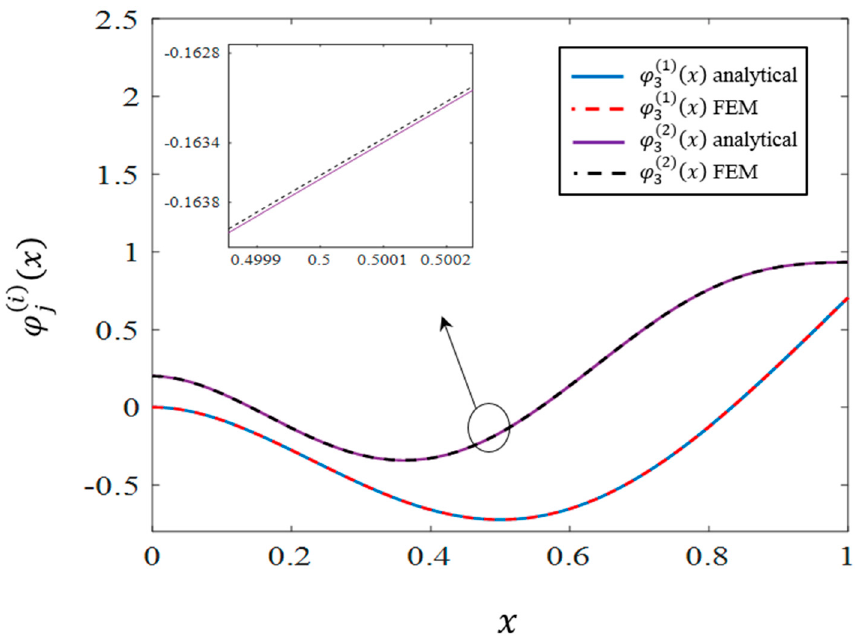
Figure 4. Comparison of the analytical and numerical shapes corresponding to the third mode.